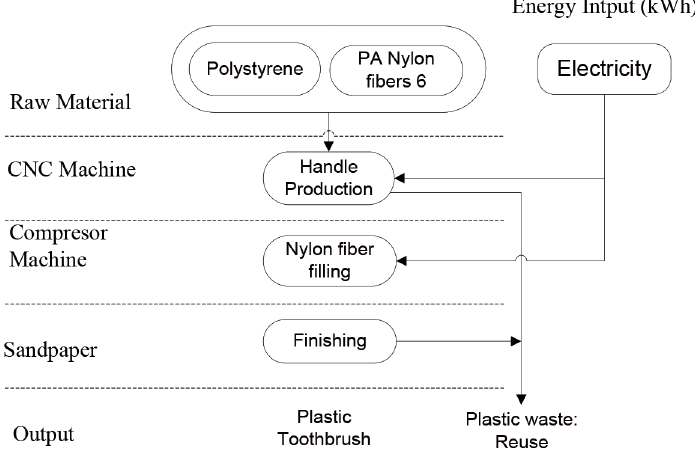
Figure 6. Process production of polystyrene